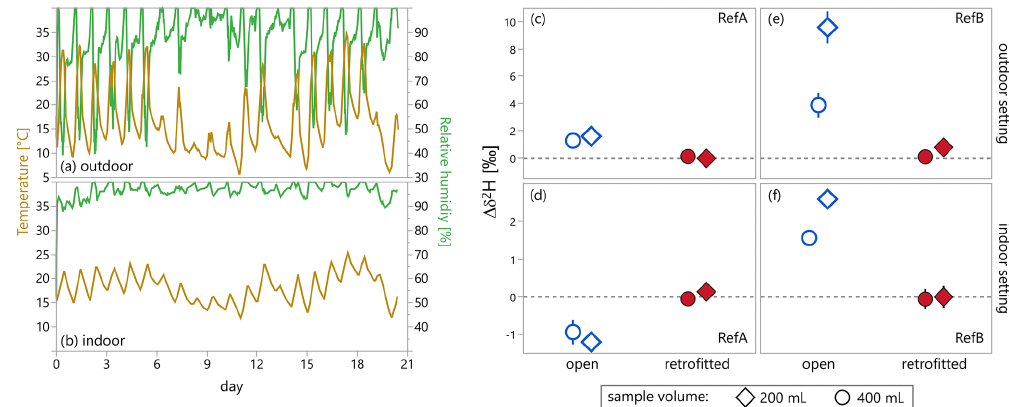
Figure 4. (a, b) Temperature (yellow) and relative humidity (green) measured inside the ISCO autosamplers that were located outdoors (a) and indoors (b) over the 21d of Experiment 2. (c–f) Mean change in isotopic composition of samples relative to the reference waters. Each data point is calculated from the three replicates of each combination of the two reference waters (RefA vs. RefB), the two sample volumes (200mL vs. 400mL), and the two bottle types (open vs. retrofitted with evaporation protection). Please note that the y -axis scales differ between the upper (c, e) and lower (d, f) panels. Error bars denote standard errors of the three replicates of each condition and account for measurement uncertainty and the standard error of the sample